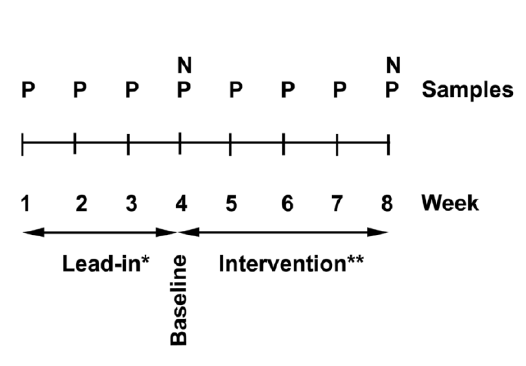
Figure 1. Study design; a three-week lead-in phase to stabilise vitamin C intake (*), was followed by a four-week intervention with two SunGold kiwifruit/day (**). Plasma vitamin C levels (P) were monitored weekly and neutrophils (N) were collected at